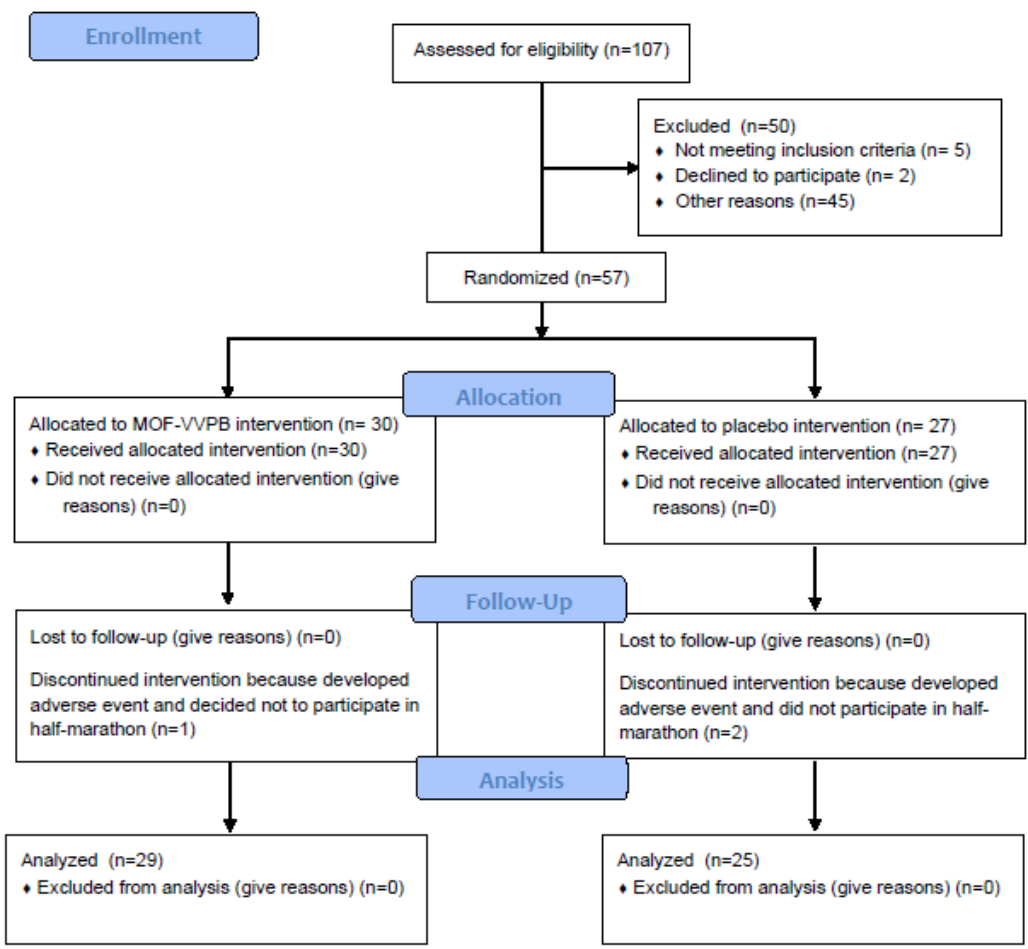
Figure 1. Study progress CONSORT diagram. AE, adverse events and CONSORT, Consolidated